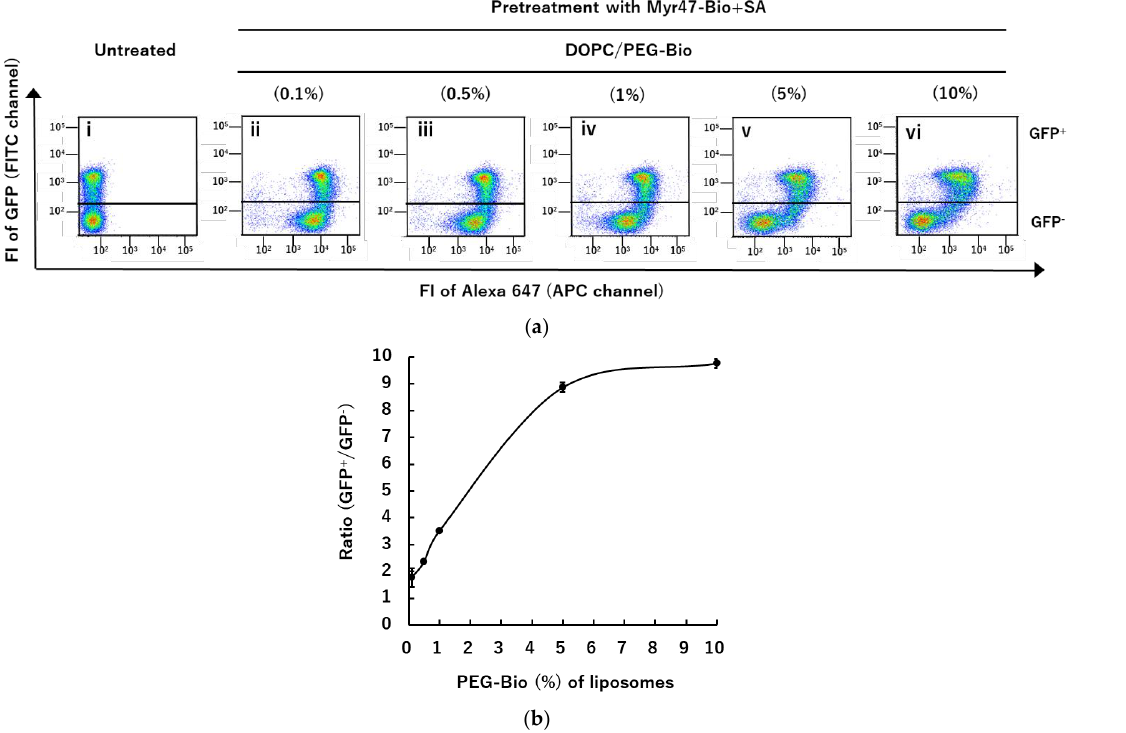
Figure 7. Contents of a biotinylated phospholipid required for specific binding of liposomes to NTCP via Myr47-Bio+SA. ( a ) HEK293T cells expressing NTCP-GFP were pretreated with Myr47-Bio+SA and then the binding of DOPC liposomes containing the indicated percentage of DSPE-PEG-Biotin (PEG-Bio) to these cells was analyzed using flow cytometry. To obtain dot plot data, we analyzed 30,000 cells. ( b ) The ratios of GFP + to GFP − subsets (FI) in the binding of DOPC liposomes containing indicated amounts of PEG-Bio are shown. Data were expressed as means ± standard errors (vertical bars) in triplicate